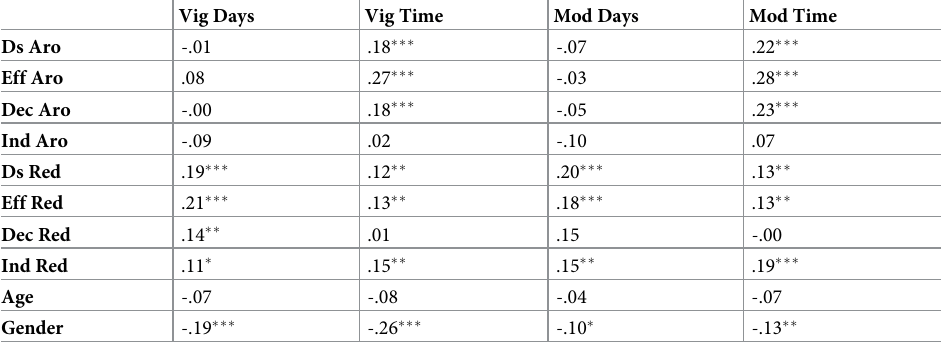
Table 6. Correlations of exercise variables with dissonance-related variables, age, and gender (Study 2). Vig